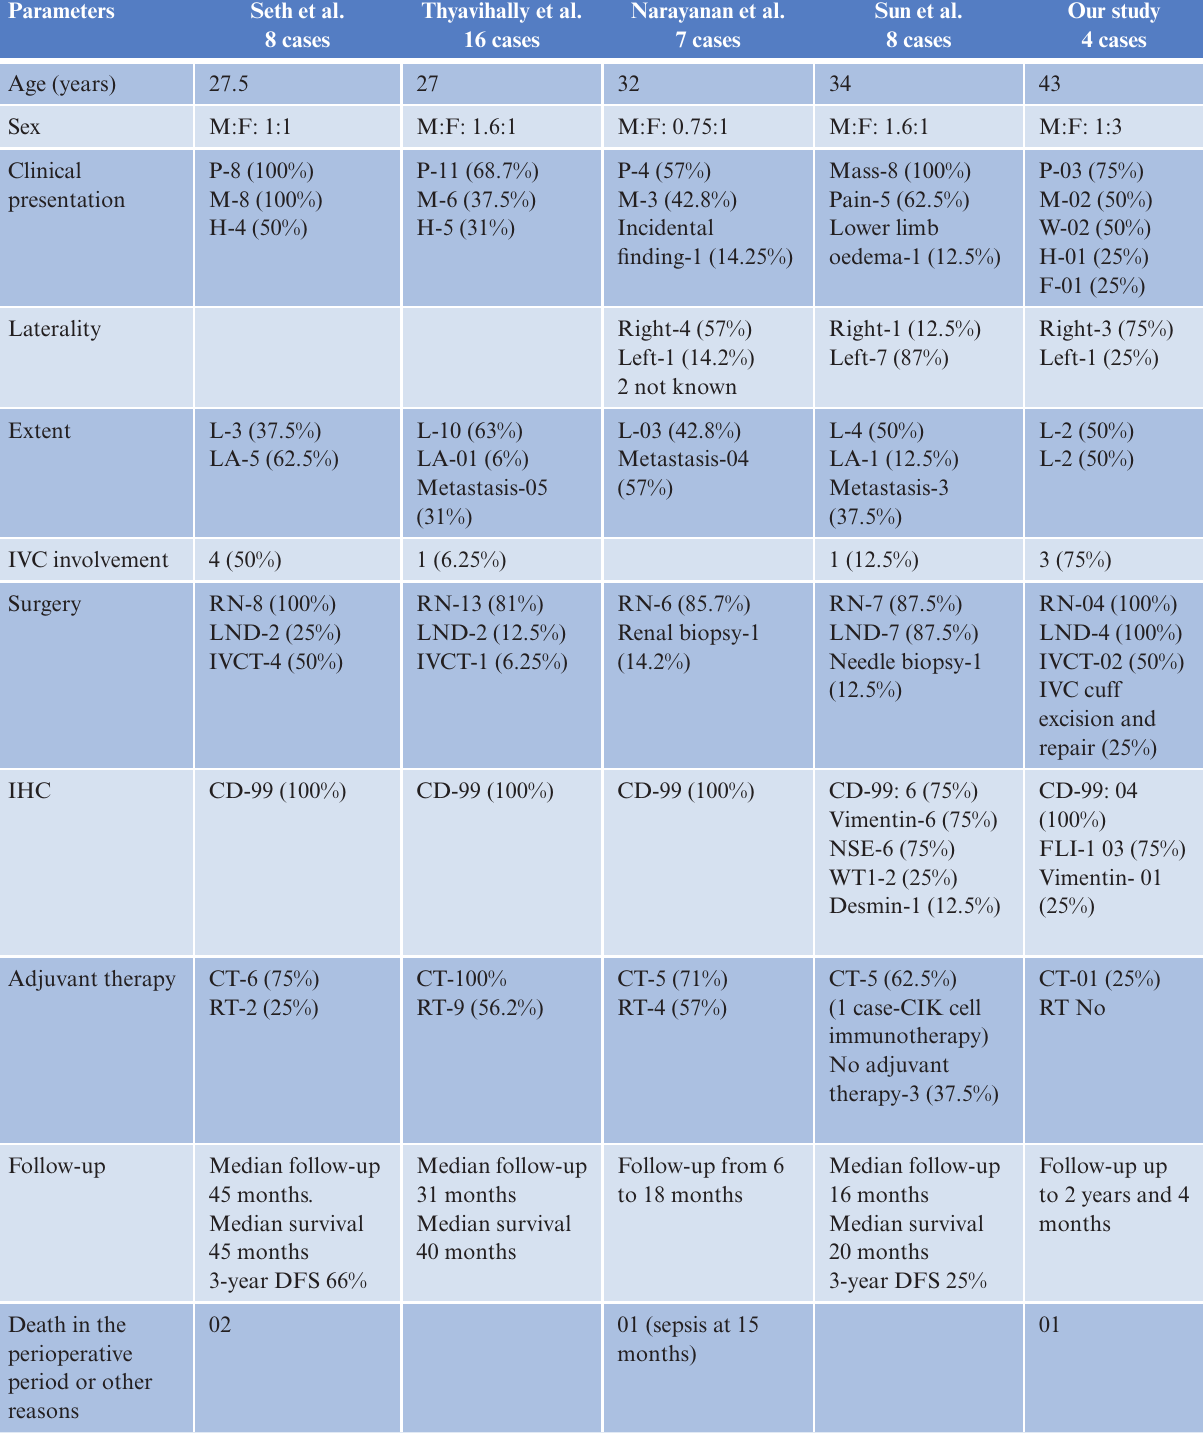
Table 2: Review of literature for clinical presentation, and treatment and follow-up of renal PNET.